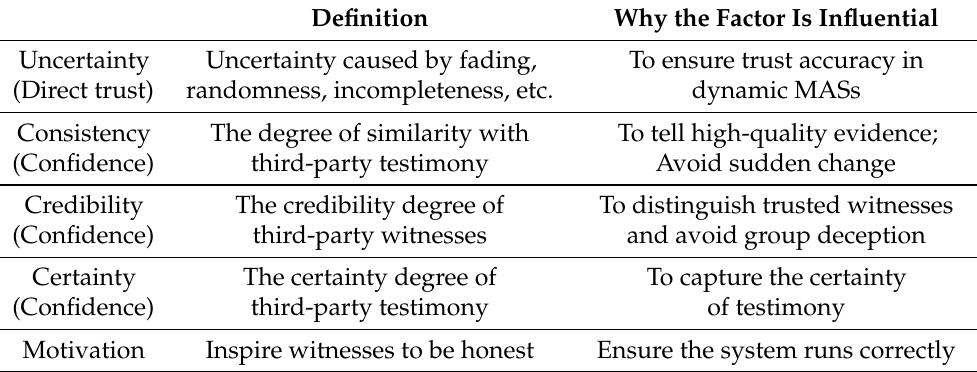
Table 1. Influential factors for trust estimation in